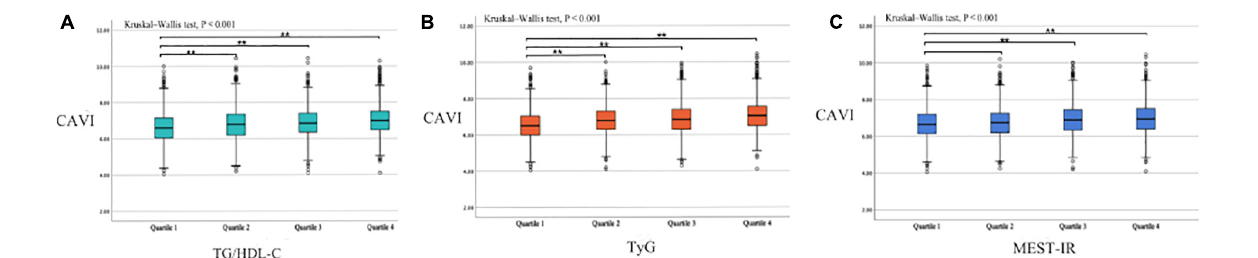
FIGURE 1 | Box plots showing the CAVI value according to each non-insulin-based insulin resistance index quartile. (A) TG/HDL-C quartiles; (B) TyG quartiles; (C) METS-IR quartiles. Center lines show the medians, box limits indicate the 25th and 75th percentiles, whiskers extend the interquartile range from the 25th to 75th percentiles 1.5 times, and outliers are represented by dots. CAVI, cardio–ankle vascular index; TG/HDL-C, triglyceride to high-density lipoprotein cholesterol ratio; TyG, fasting triglyceride and glucose index; METS-IR, metabolic score for insulin resistance. ** p < 0.05.